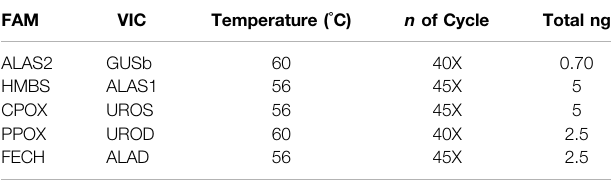
TABLE 3 | dPCR conditions for all genes.